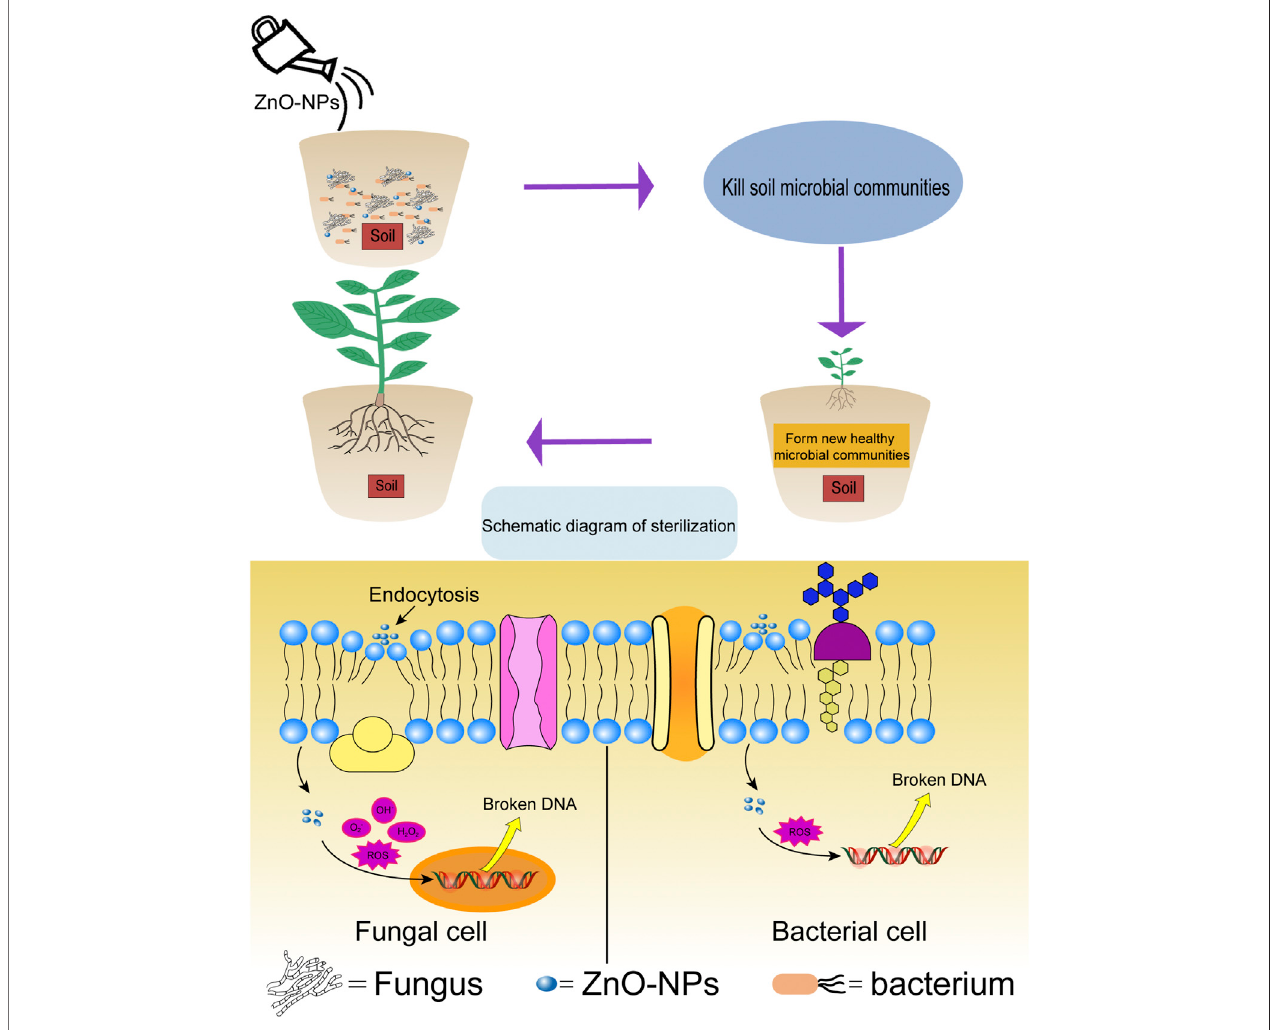
FIGURE 9 | The mechanism of ZnO-NPs overcoming